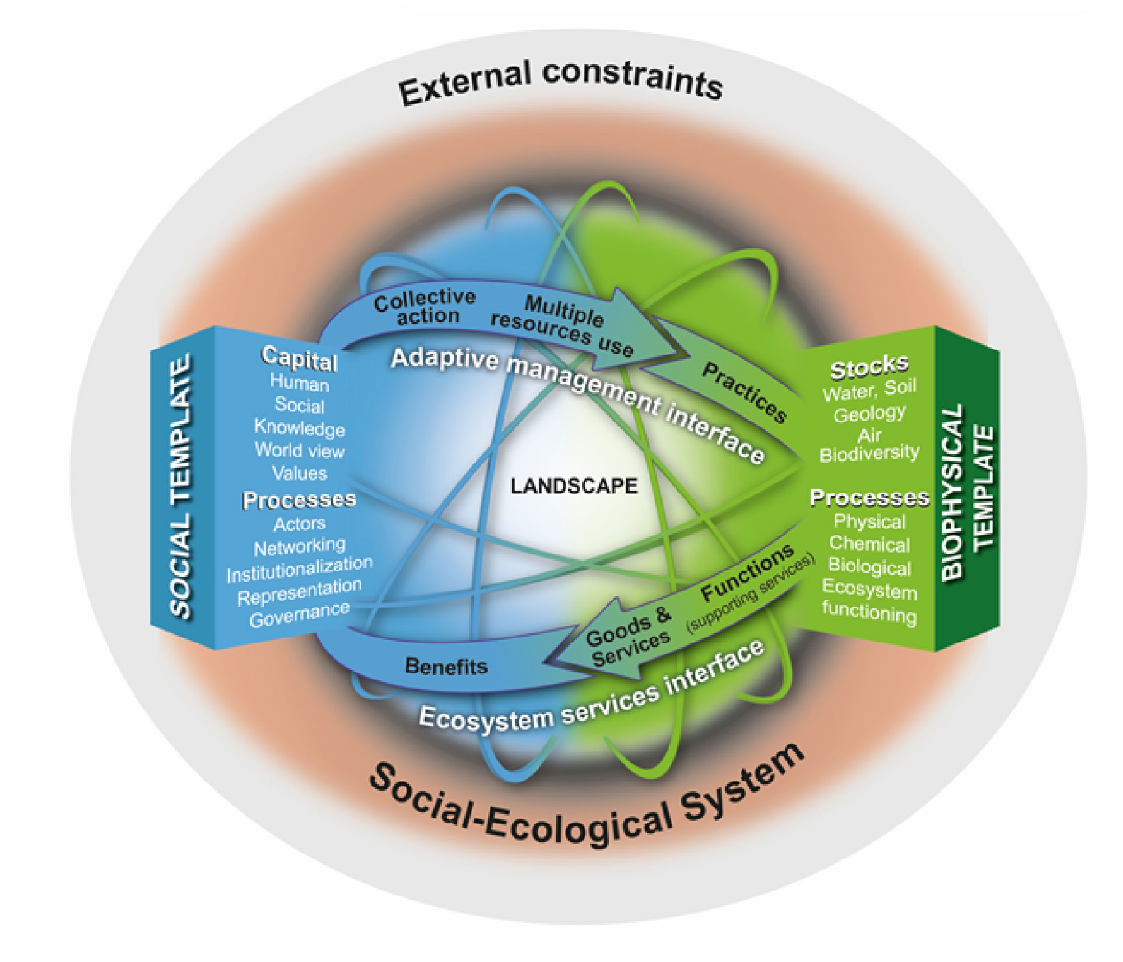
Fig. 1 . The conceptual framework of the social ecological system (SES) within the French long-term social- ecological research platforms. The SES as an entity is composed of two coupling interfaces, the adaptive management interface and the ecosystem services interface, both set within an explicit landscape context. The originality in this framework is the emphasis on explicit components that will directly contribute to changing the trajectory of the